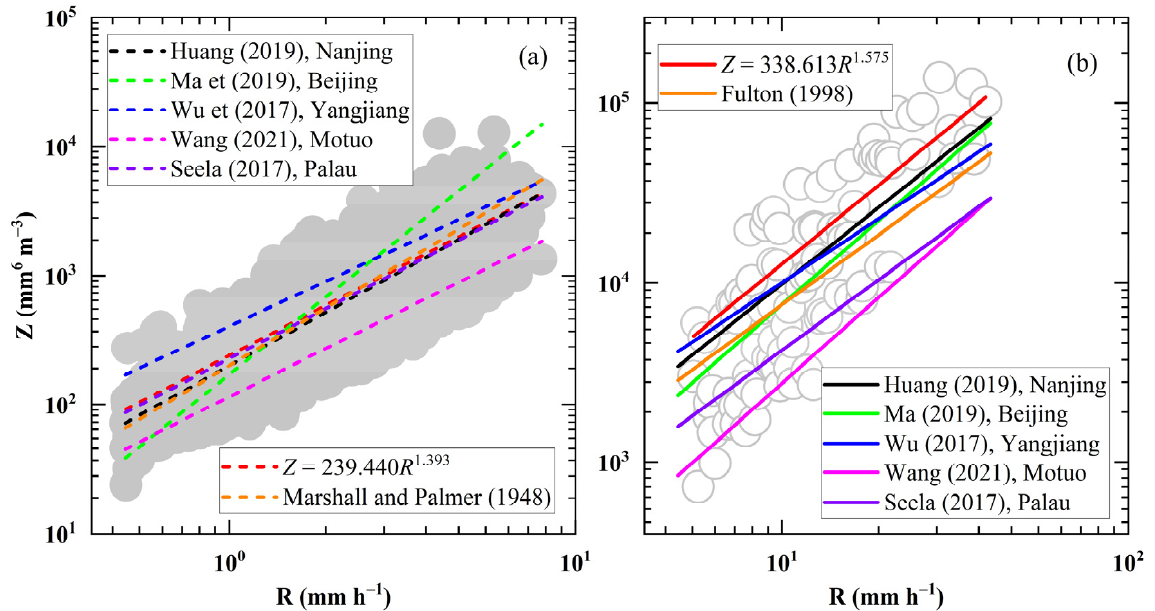
Figure 7. Scatterplots of Z versus R , and the Z – R relations represented by red line and equation for ( a ) stratiform (grey solid circle and dotted line) and ( b ) convective (grey dotted circle and solid line) rainfall in Zhaosu. Previous results in Nanjing [86], Beijing [43], Yangjiang [87], Motuo [34], and Palau [24] for stratiform (dotted line) and convective (solid line) rainfall are presented with corresponding colors. The widely used Z – R relations proposed by Marshall and Palmer [88] for stratiform rainfall and Fulton et al. [89] for convective rainfall are also shown in orange in Figure 7.